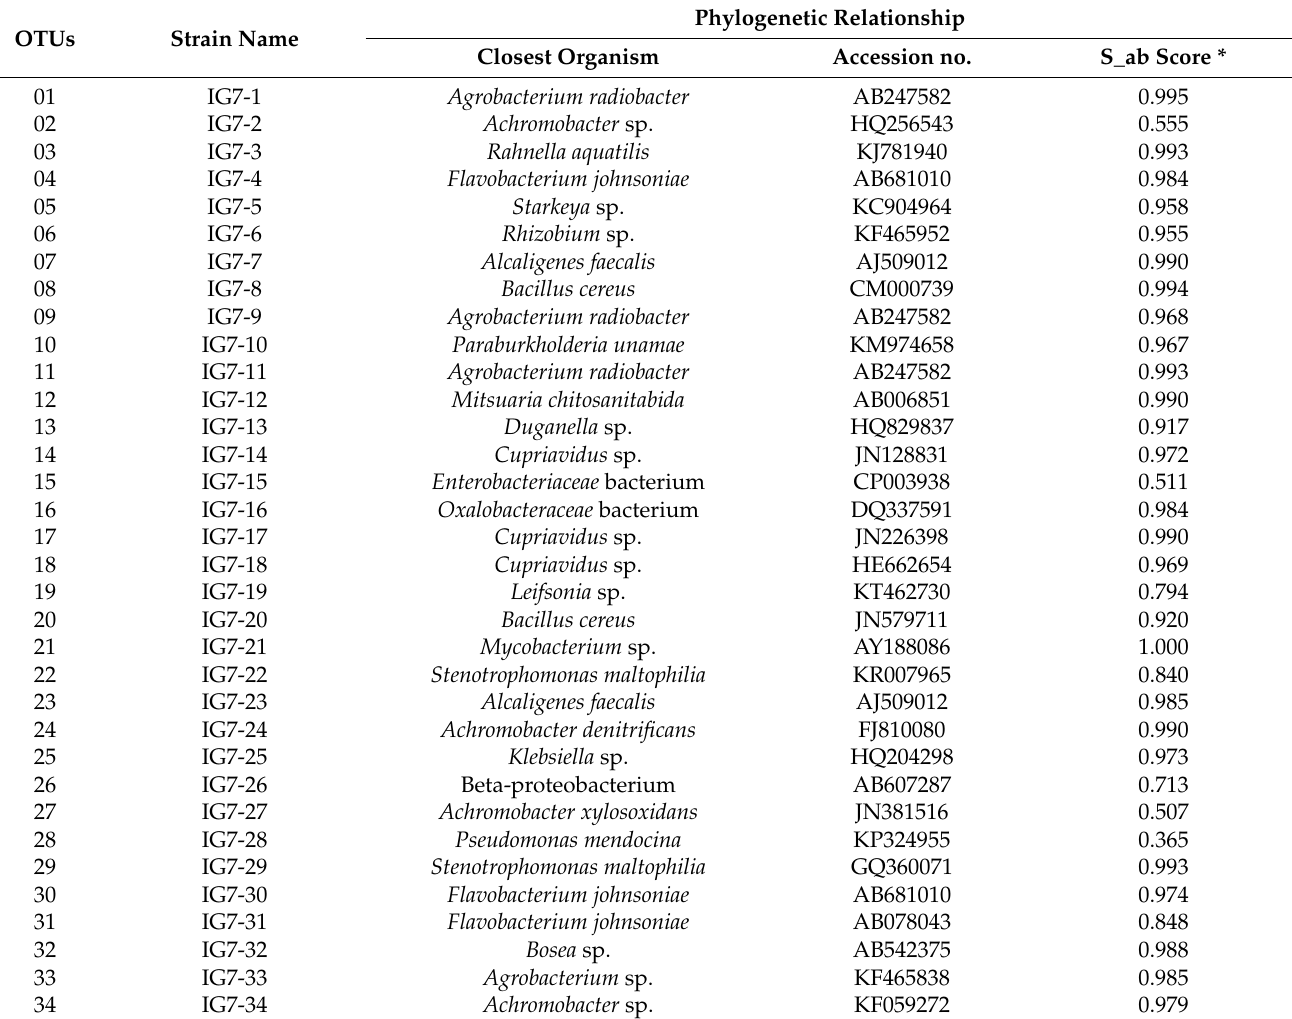
Table 4. Taxonomic identification of representative strain for the ARDRA-based